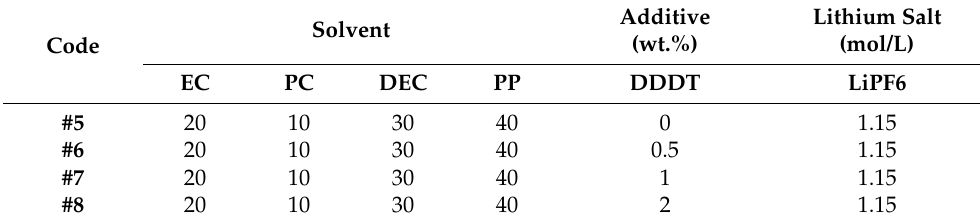
Table 2. Compositions of electrolytes